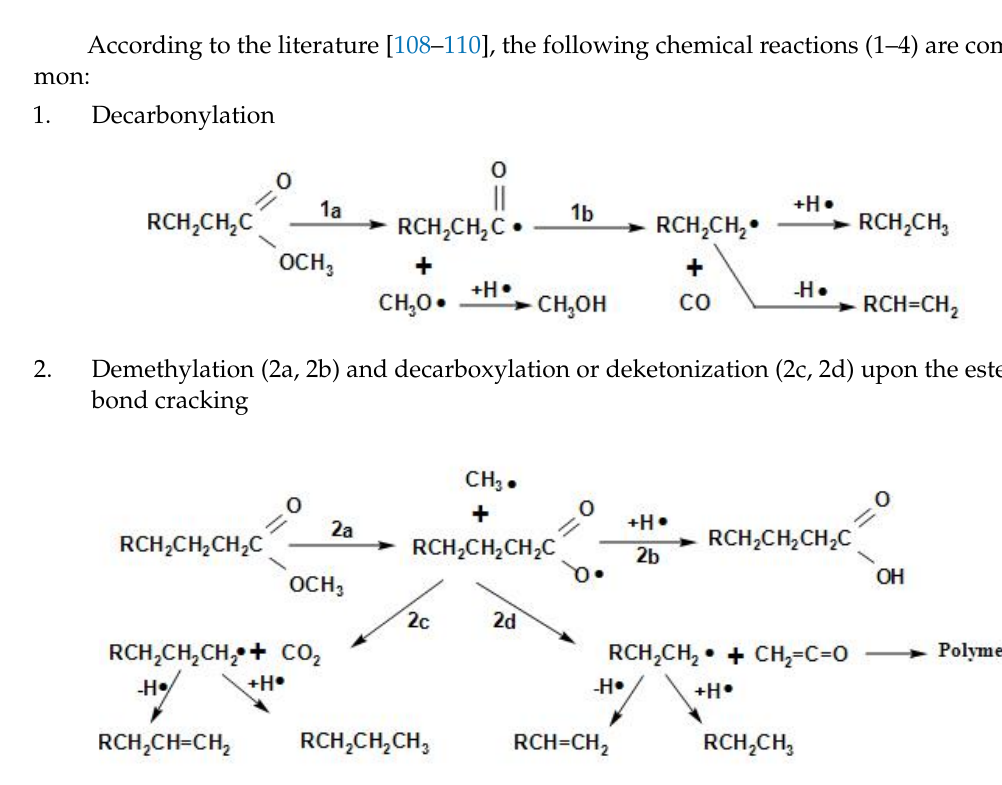
Figure 13. Proposed overall reaction pathways for the catalytic cracking of the algal HO for parent HZSM-5 and Lanthanum-Cerium modified zeolites.